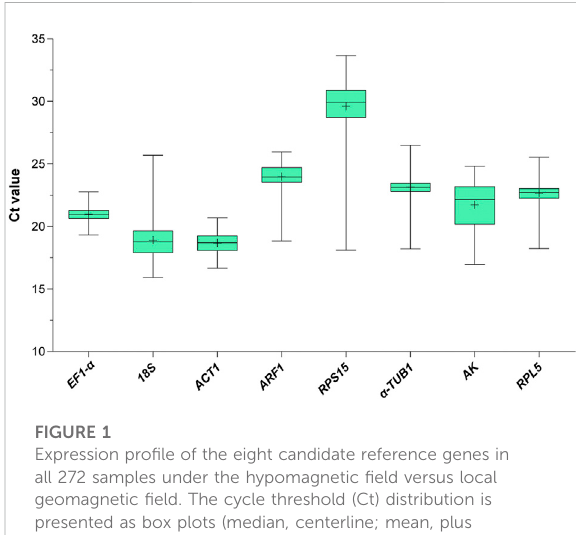
FIGURE 1 Expression pro fi le of the eight candidate reference genes in all 272 samples under the hypomagnetic fi eld versus local geomagnetic fi eld. The cycle threshold (Ct) distribution is presented as box plots (median, centerline; mean, plus symbol; interquartile range (IQR), box; maximum and minimum values,